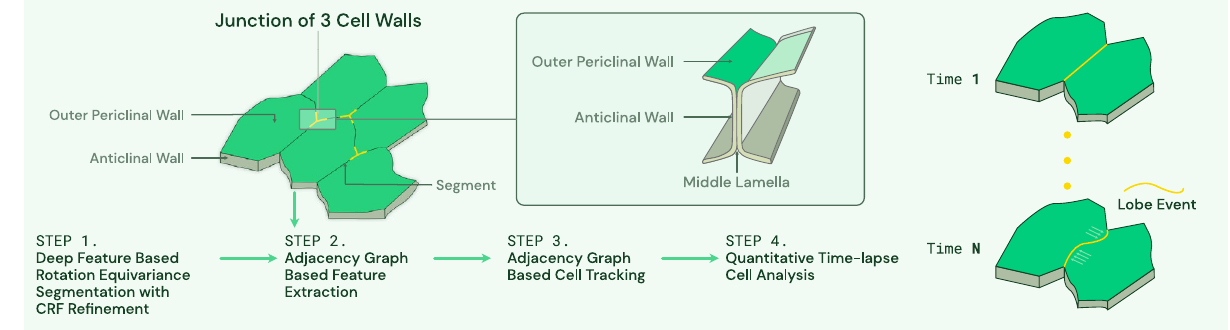
Figure 1. Workflow of proposed method. Modified from 4 . Given a sequence of 3D image stacks, deep feature based rotation equivariance deep learning model with CRF refinement is used to segment each cell. Then adjacency graph is built based on segmented image and used for sub-cellular feature extraction and tracking. Sub-cellular features such as junction of three cell walls and anticlinal wall segment are illustrated in the figure. Next detected segments will be used in 5 to detect lobes. This paper mainly focuses on Step 1 to Step